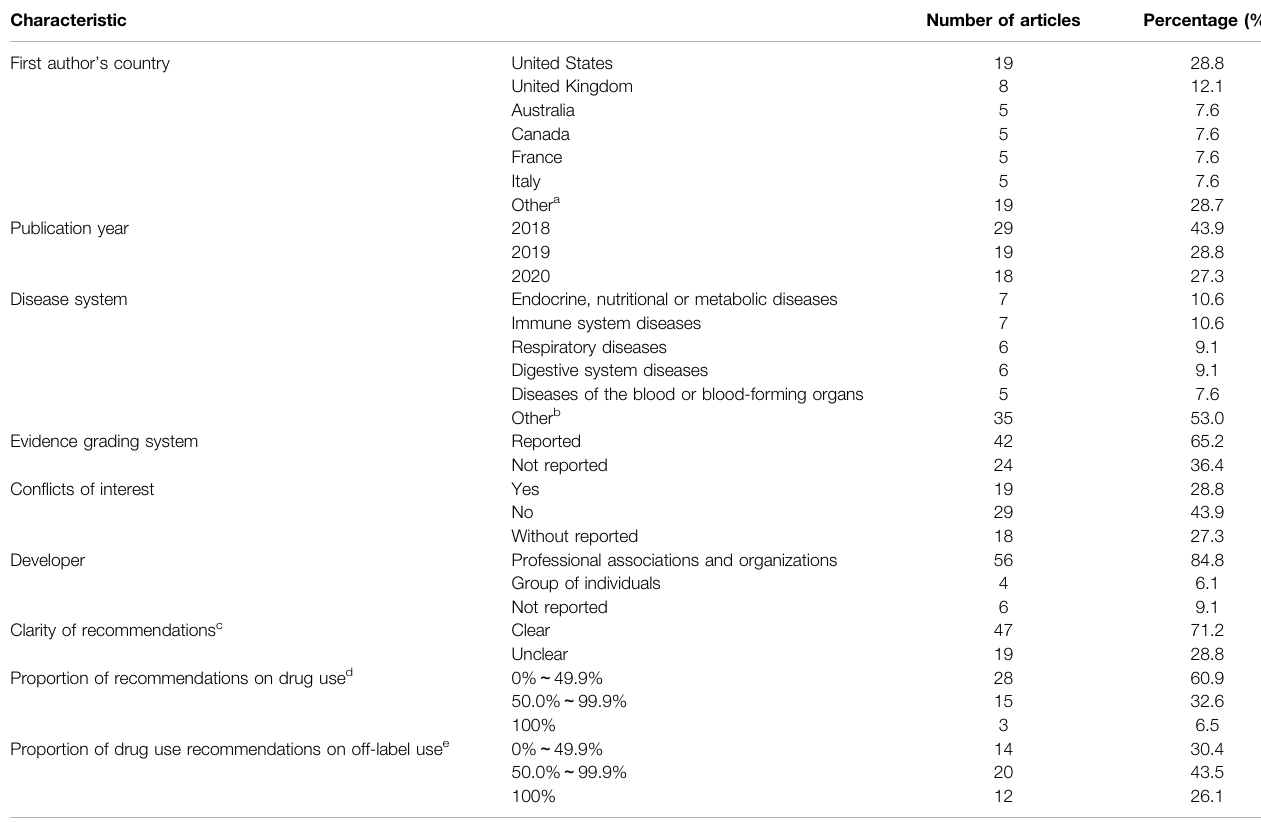
TABLE 1 | Characteristics of the included